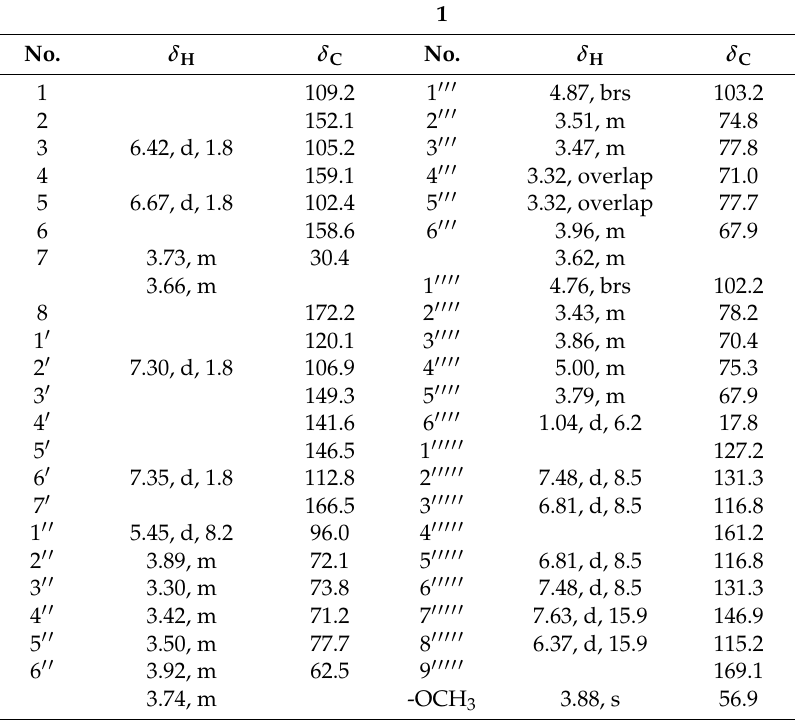
Figure 2. 1 H- 1 H COSY ( ) and key HMBC ( ) and ROESY ( ) correlations of 1 . Table 1. 1 H (600 MHz) and 13 C NMR (150 MHz) data of 1 ( δ in ppm, J in Hz, methanol- d 4 ).